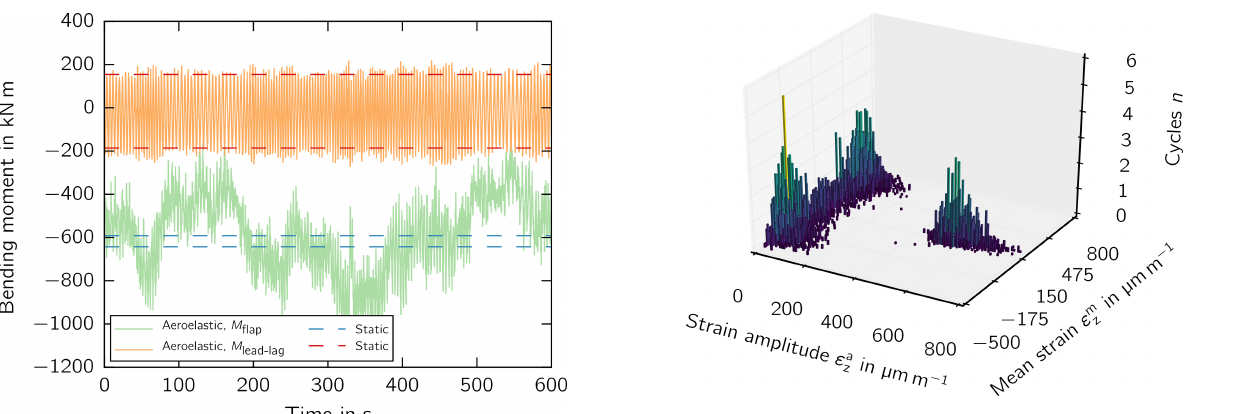
Figure 4. Moment history at z = 10 . 2m and v = 9ms − 1 for yaw error (cid:57) = 0 ◦ and seed s = 0.